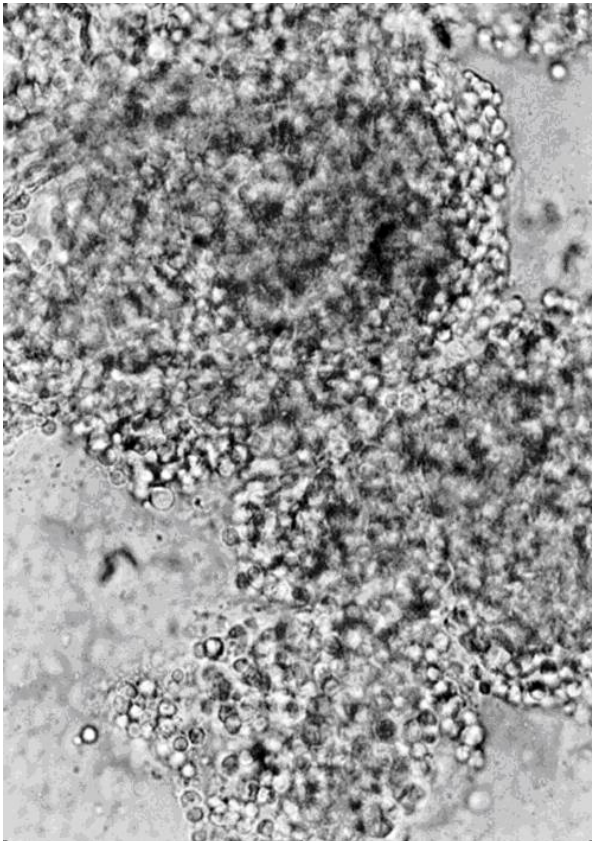
Figure 2. Photograph of agglutinated mouse lymphocytes induced by acutolysin C (40x). The reaction was conducted in Hanks solution with 10 μg/mL of acutolysin C and 5.8 x 10 7 lymphocyte cells/mL at 25°C for 30